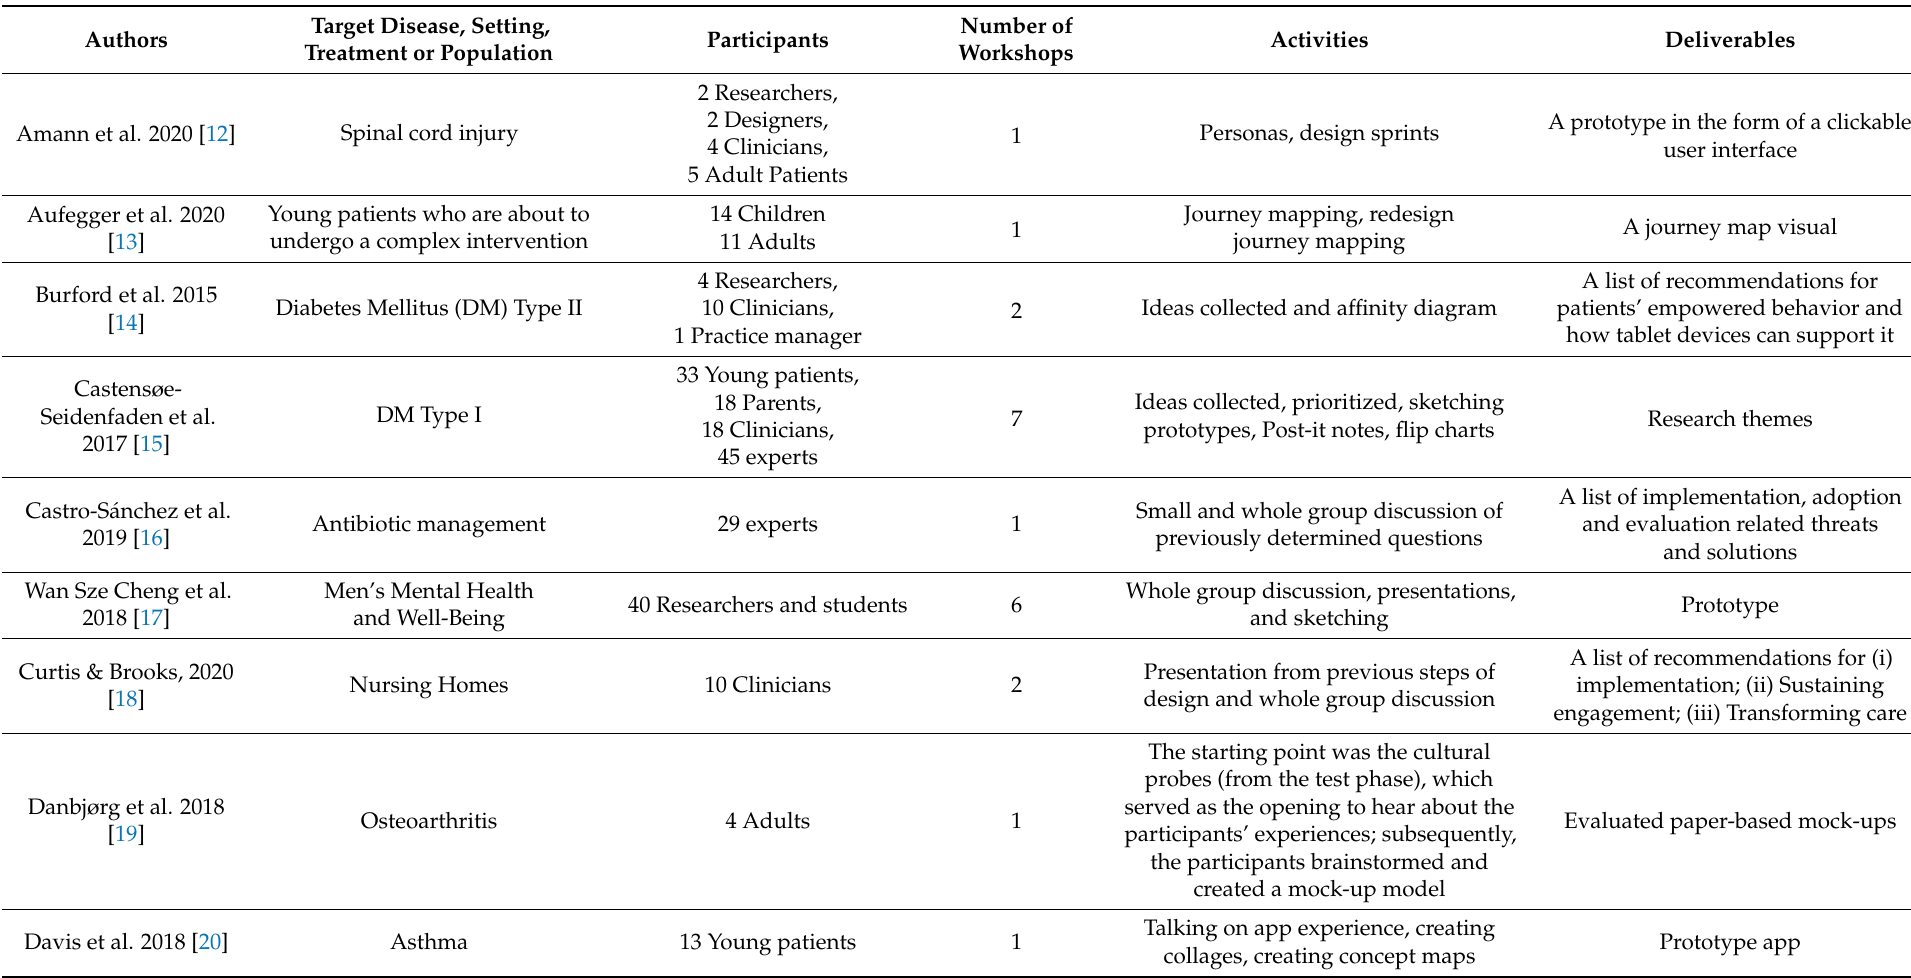
Table 1. Summary of Results of 62